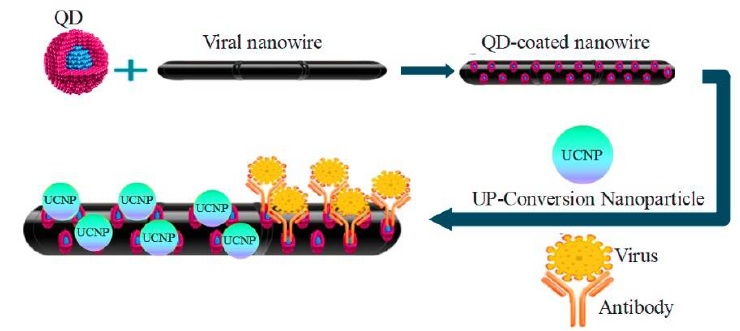
Figure 4. QD-coated viral nanowire for detecting pandemic viruses.